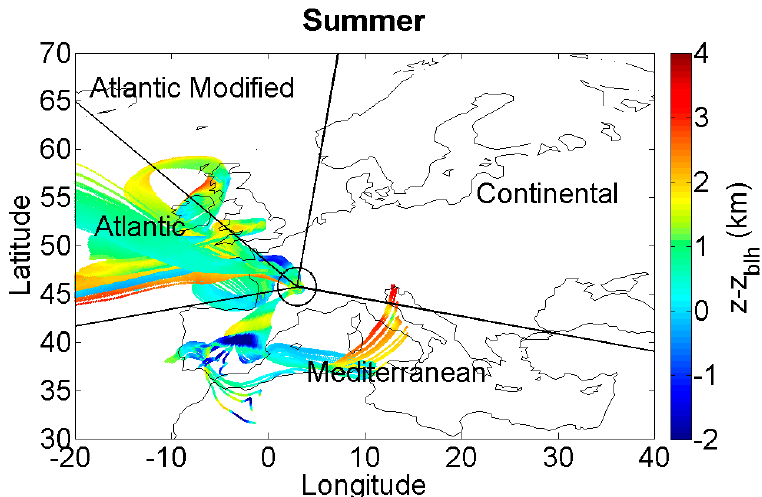
Figure A3. The 204-h ECMWF backward trajectories for air masses arriving at the PUY site during FT sampling periods. The color scale represents the difference between the calculated height (z) of the air mass trajectory and the calculated height of the BL/RL height (Z-Z blh (km)).